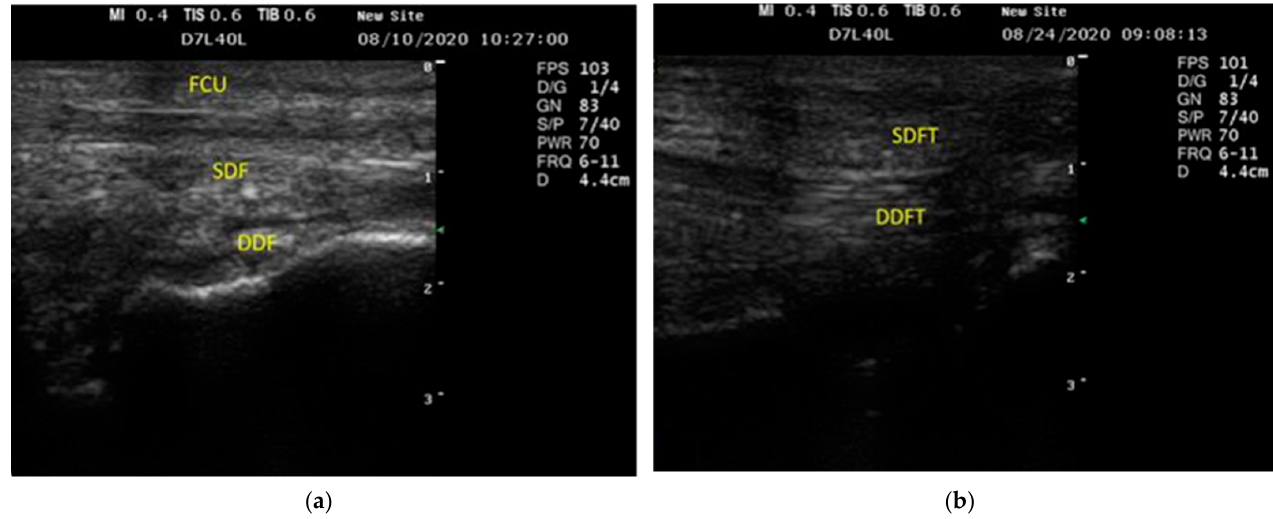
Figure 3. The longitudinal ultrasonographic image of the palmer feature of the carpal multiparty in donkeys showed that the superficial digital flexor muscle seemed to have a heterogeneous echogenic structure with mixed anechoic and echogenic bands. In contrast, the deep digital flexor muscle appeared to be a heterogeneous echogenic structure. ( a ) FCU, flexor carpi ulnaris muscle; SDF, superficial digital flexor muscle; ( b ) DDF, deep digital flexor muscle; SDFT, superficial digital flexor tendon; DDFT, deep digital flexor tendon.